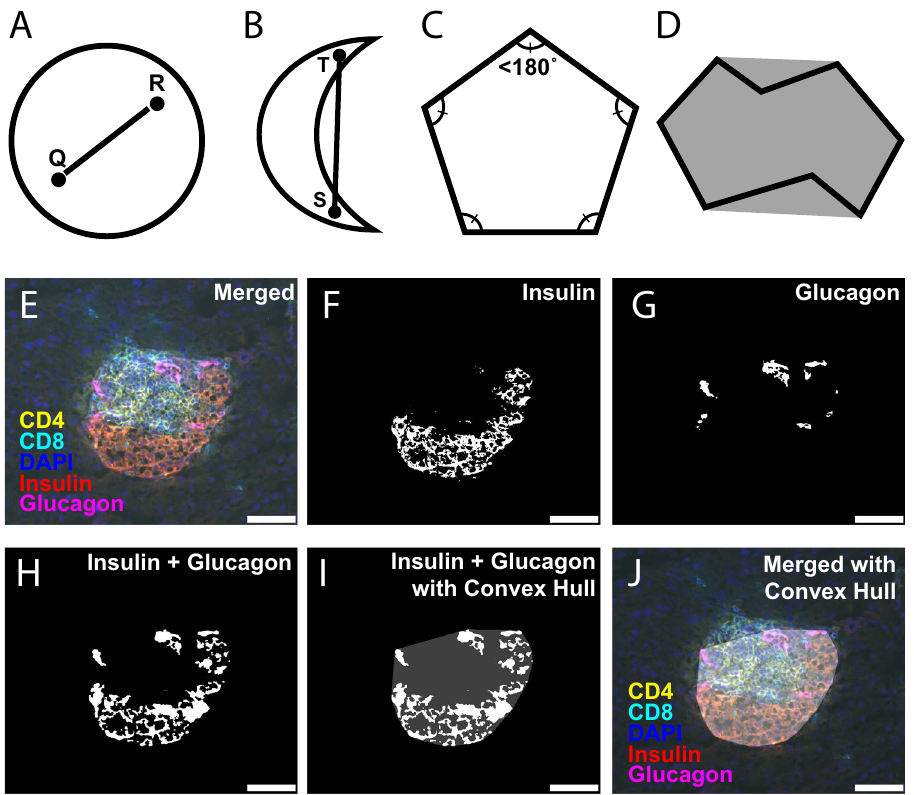
Figure 2. Inflamed islet borders can be defined using insulin, glucagon and a convex hull based geometrical approach. Convex hulls are two-dimensional convex polygons that can model cross-sectional images of pancreatic islets. ( A ) A circle is an example of an entirely convex shape since all segments of a straight line connecting any two randomly selected points (Q, R) within the shape lie inside the shape borders. ( B ) A crescent is an example of a shape that is not entirely convex because a straight line connecting the two points (S, T) exists outside the shape borders. ( C ) A pentagon is an example of a convex polygon because all interior angles are less than 180°. ( D ) A convex hull (grey region) is depicted to demonstrate the area that entirely encloses all points of a mixed concave/convex polygon (black outline) with the smallest possible area. ( E – J ) Examples of the convex hull methodology using an acquired image of an islet from a 13-week-old non-diabetic NOD mouse. ( E ) Merged image with CD4 (yellow), CD8 (cyan), DAPI (blue), insulin (red) and glucagon (magenta) staining. ( F ) Individual thresholded 8-bit insulin image. ( G ) Individual thresholded 8-bit glucagon image. ( H ) Combined insulin and glucagon images from ( F ) and ( G ). ( I ) Convex hull (transparent white) of combined insulin and glucagon images. ( J ) Original merged image with overlaid convex hull (transparent white). White bars represent 50 μm